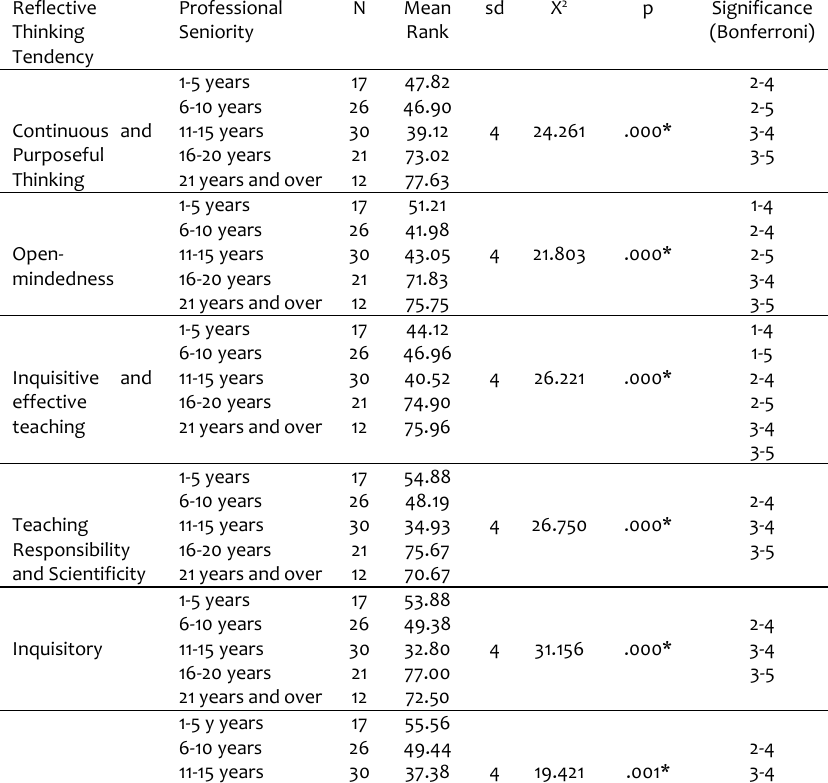
Table 4. The Kruskal Wallis H-test results associated with the sub-dimensions of the reflective thinking tendency scale according to the professional seniority of preschool teachers Reflective